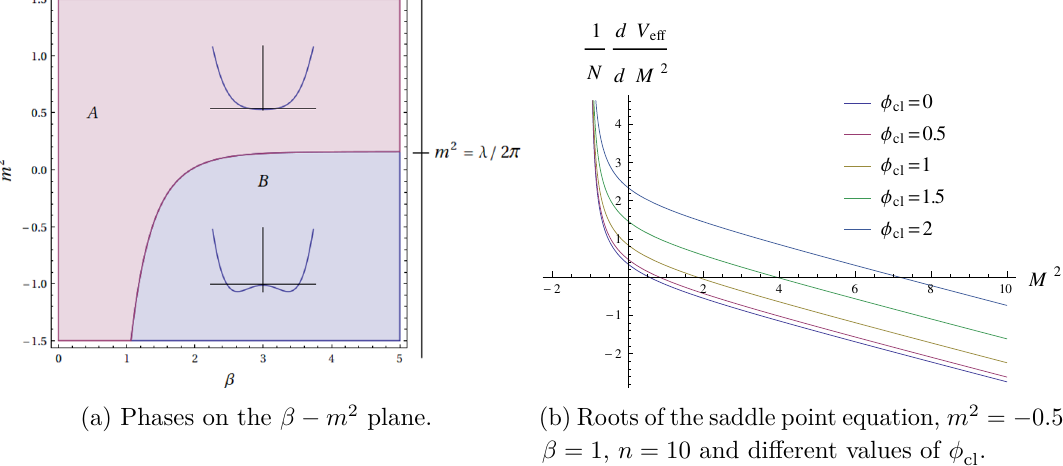
(a) Phases on the β − m 2 plane.